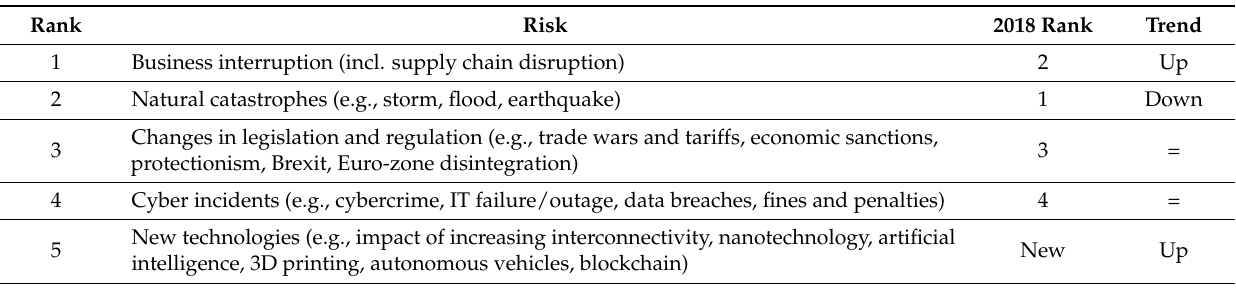
Table 4. Top 5 risks in renewable